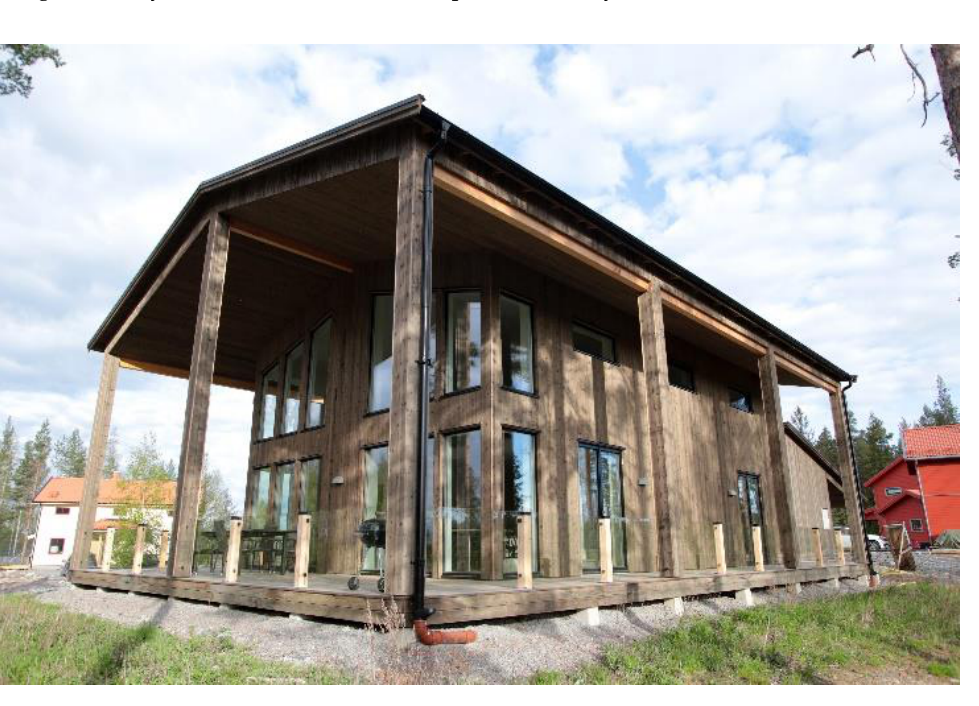
Figure 1. The study object Dalarnas Villa. Table 3. Input data including main building materials applied in the case study, modified [44].